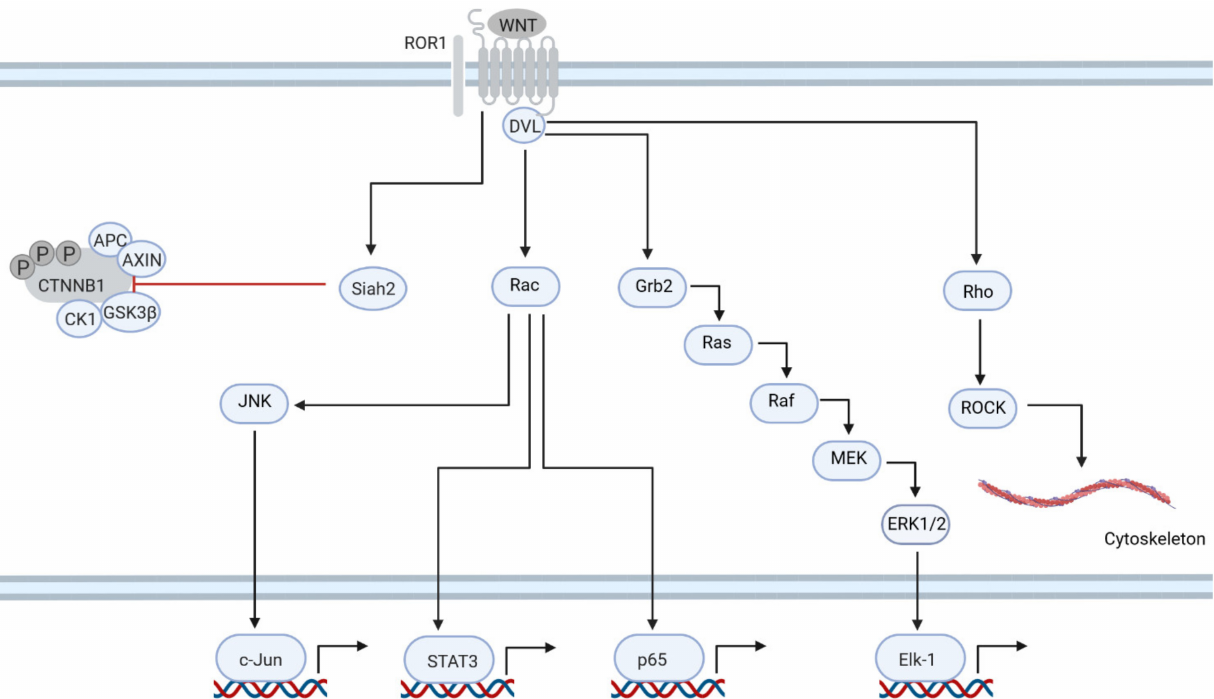
Figure 2. WNT/PCP signaling is specific to CLL and central to the pathomechanism. ROR1 plays a central role in CLL pathogenesis. ROR1 signaling regulates (1) canonical signaling via Siah2 E3 ligase; (2) cell migration via Rho and ROCK kinases; (3) cell adhesion via JNK kinase; (4) proliferation via Ras cascade; (5) NF-kB pathway; (6) STAT3